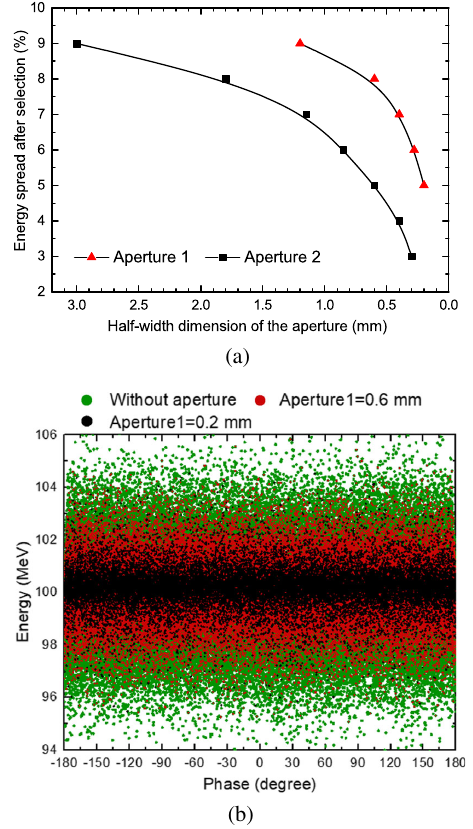
FIG. 2. Simulation results in the collection section, showing (a) relationship between aperture size and energy selection for the two apertures; and (b) final phase – energy distribution from multiparticle simulation when adjusting the first aperture.